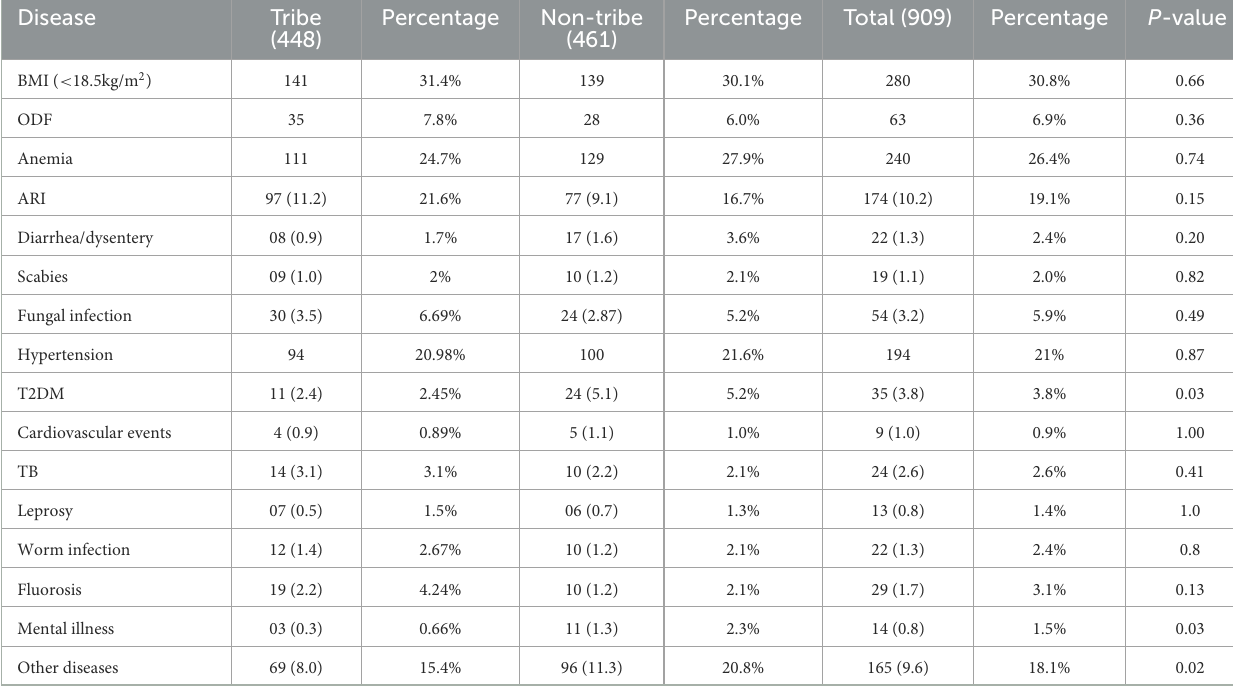
TABLE 5 Percent prevalence of diseases in the tribe and non-tribe study population. Disease Tribe